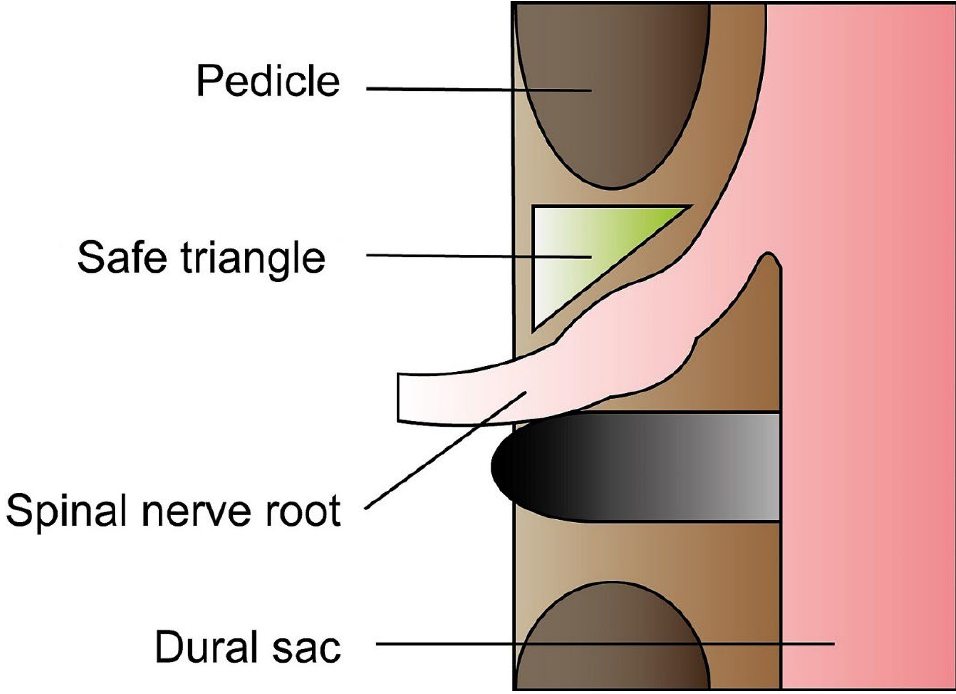
Figure 3. Representation of safe triangle and its boundaries.